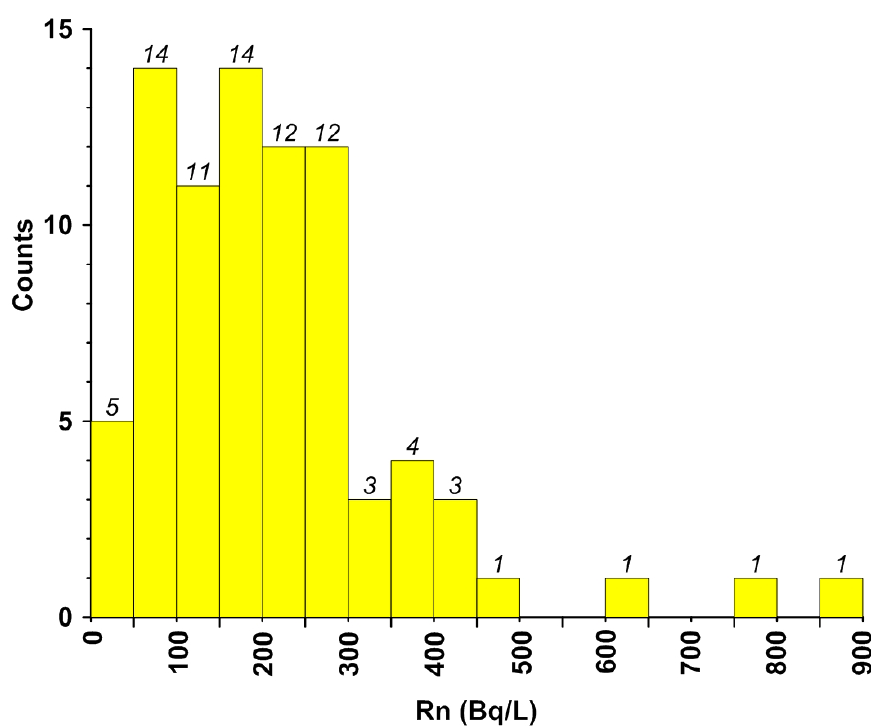
Figure 5. Histogram showing the distributions of a wide range of radon concentrations in groundwater. The radon concentrations in most samples are lower than 300 Bq / L. Italic values on the top of bars denote sample numbers. The width of each bar corresponds to 50 Bq / L range.